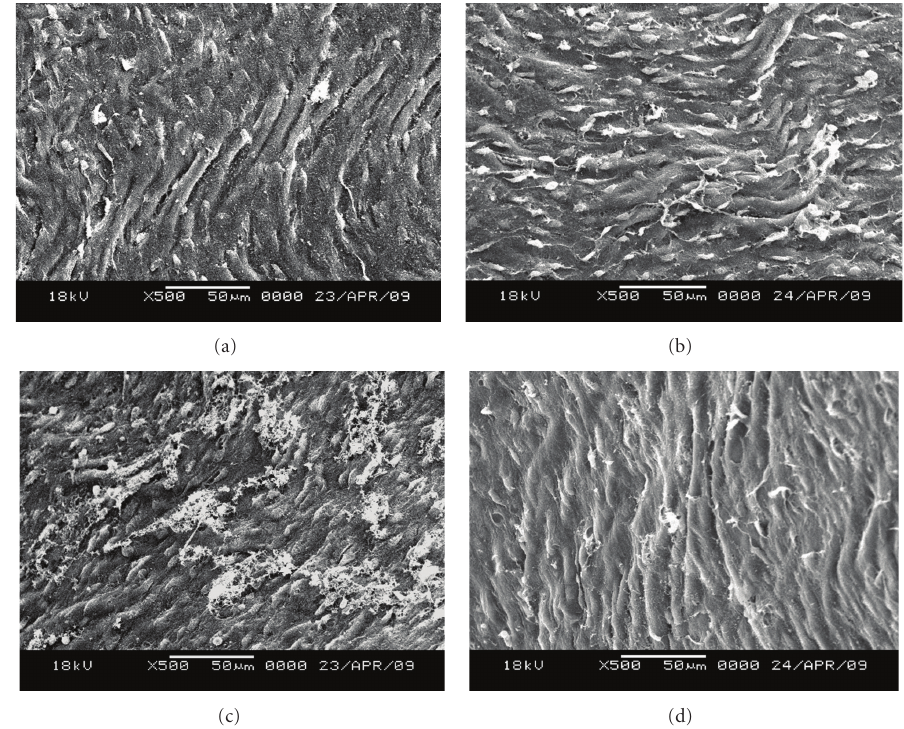
Figure 5: Scanning electron microscope (SEM) observation of inner walls of thoracic aortas ( × 500). (a) Con; (b) Met; (c) OVX + Met; (d) OVX + Met + GST. The tunica intima was smooth and intact with flat endothelial cells in both Con and Met group. In OVX + Met, the impairment of endothelial cells was very serious with some endothelial cells atrophy, deformed, desquamation, and some fibrin adherent to the endothelium surface. In OVX + Met + GST , the endothelium damage was slight with tunica intima almost intact.